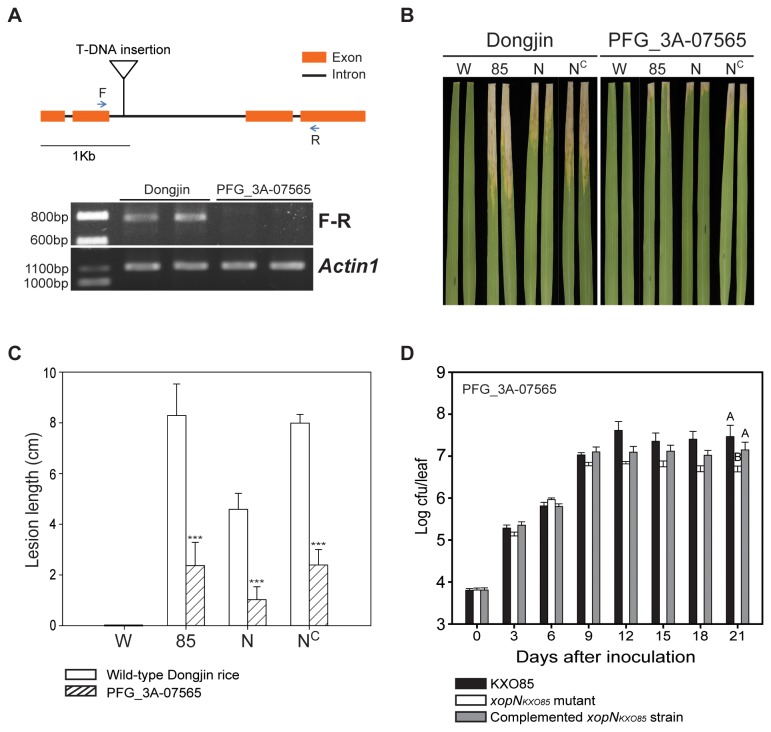
Virulence assay in wild-type Dongjin rice and the OsVOZ2 mutant line PFG_3A-07565.
A. Schematic representation of the T-DNA insertion in OsVOZ2 T7 transgenic rice. OsVOZ2 consists of four exons (orange boxes) and three introns (line between the orange boxes). The T-DNA was located in the second intron from the translational start site. F and R are the primers used for RT-PCR analysis, which showed the expected size of OsVOZ2 in wild-type Dongjin but not in the OsVOZ2 mutant rice PFG_3A-07565. Actin1 was used for normalization of the cDNA quantity. B. Virulence assay of the xopN
KXO85 mutant in wild-type Dongjin rice and OsVOZ2 mutant rice. W, water; 85, KXO85; N, KXO85 xopN
KXO85::EZ-Tn5; and NC, KXO85 xopN
KXO85::EZ-Tn5 (pML122G2). Photographs were taken 21 days after inoculation. C. Measurement of disease severity in flag leaves of wild-type Dongjin rice (□) and OsVOZ2 mutant rice (▨). W, water; 85, KXO85; N, KXO85 xopN
KXO85::EZ-Tn5; and NC, KXO85 xopN
KXO85::EZ-Tn5 (pML122G2). Lesion lengths were determined 21 days after inoculation. Vertical error bars indicate the standard deviation (SD). The statistical significance was determined using a two-way ANOVA as compared to wild-type Dongjin rice with the post hoc Tukey HSD test (***, P<0.001). D. Growth patterns of the KXO85, xopN
KXO85 mutant, and complemented xopN
KXO85 mutant in the flag leaves of OsVOZ2 mutant rice (PFG_3A-07565). The data are the average values of three replicates; vertical bars indicate the error ranges (±SD). The bacterial populations were assessed every 3 days after inoculation. Different letters at day 21 indicate significant differences (P<0.05) as determined by a one-way ANOVA (P<0.001) followed by post hoc Tukey HSD analysis.